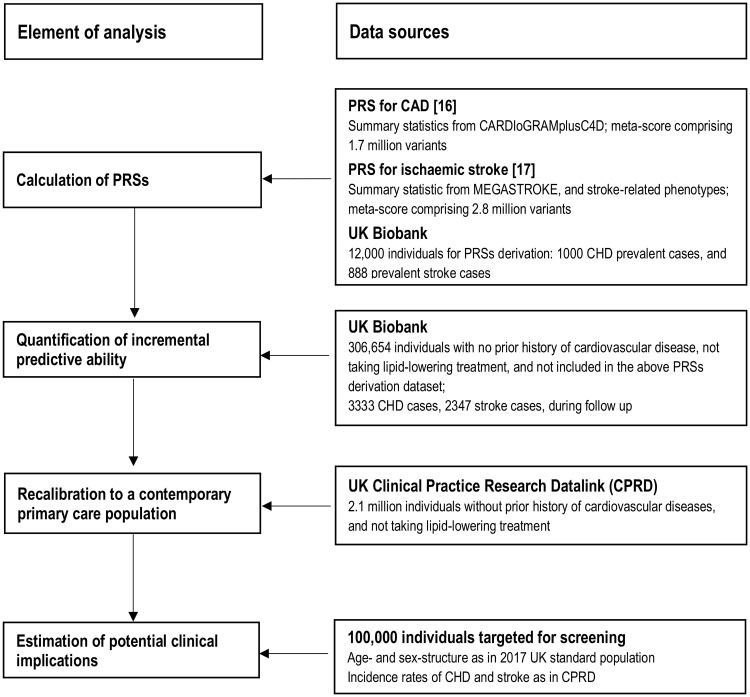
Study design and overview.CHD, coronary heart disease; PRS, polygenic risk score.